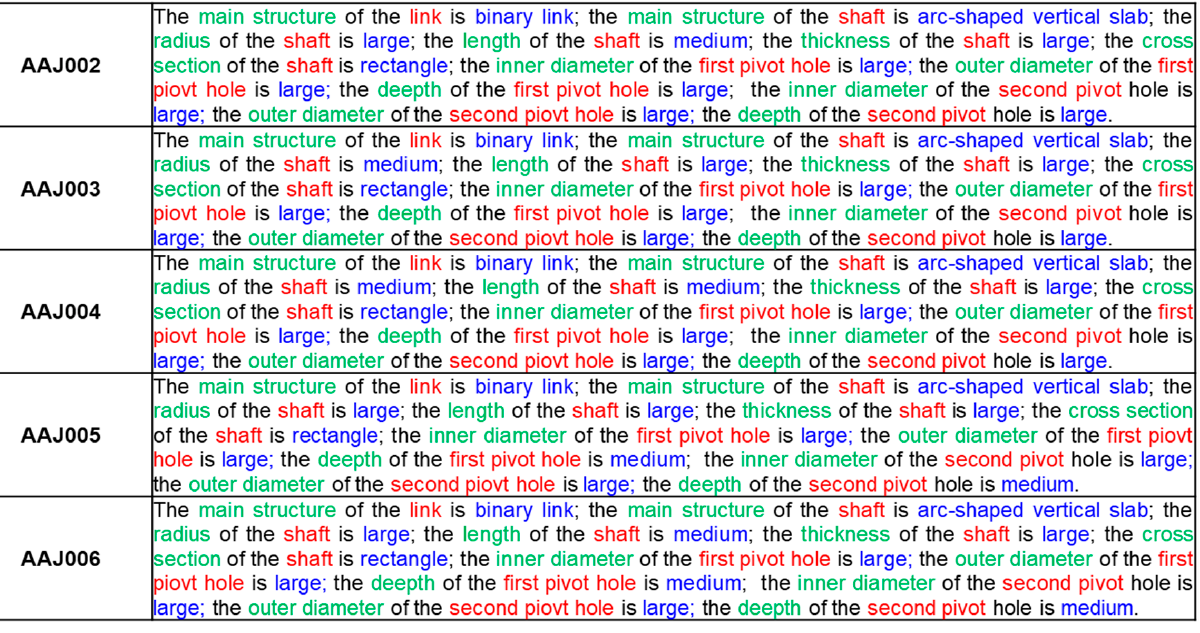
Figure 5. Examples of the texts that describe the structural features of the linking rods, which can be expressed in the form of “ Entity–Attribute–Attribute value.